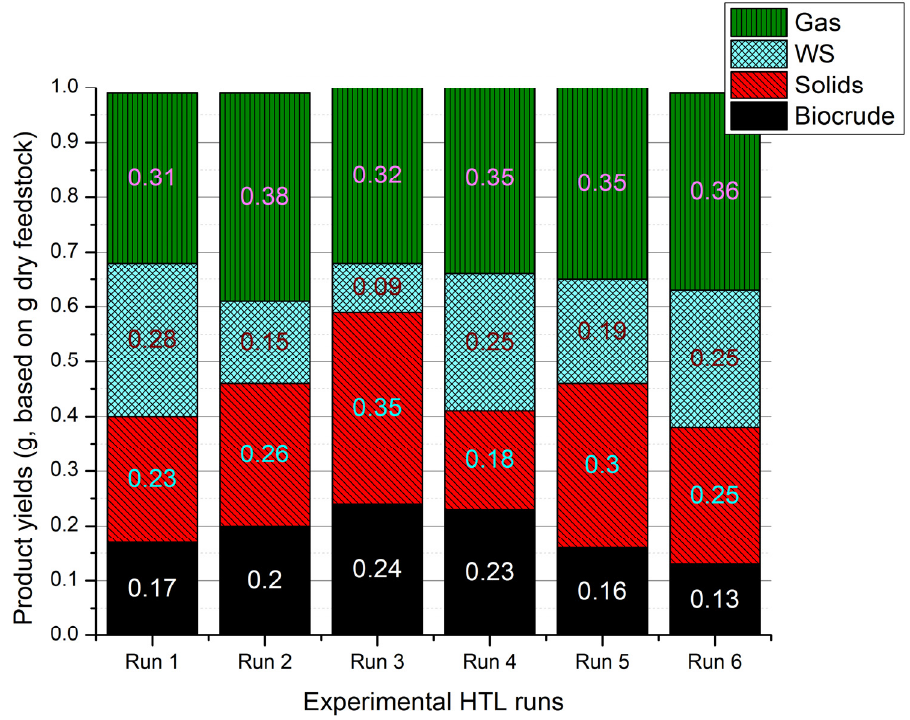
Figure 3. Overview of HTL product yields, including biocrude, solids, water solubles and gases, indiscriminately scaled to a closed mass balance.